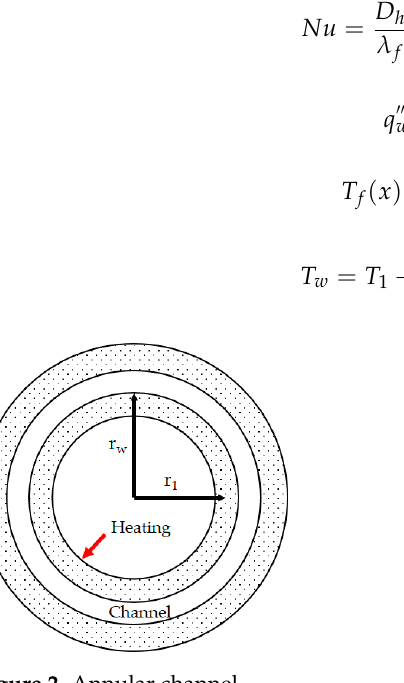
Figure 2. Annular channel.